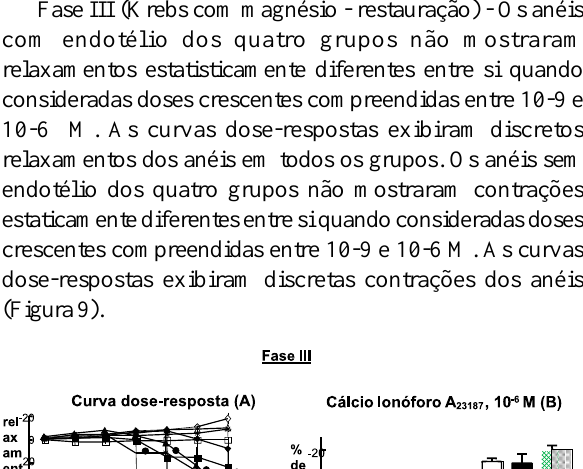
Fig. 8 - Fase II (Krebs sem magnésio): A - Curvas dose- respostas cálcio ionóforo (A ) em anéis de artérias coronárias 23187 caninas, contraídas com PGF a (2 x 10 -6 M), na presença de 2 indometacina (10-5 M); B - Efeitos da dose 10-6 M de cálcio ionóforo (A ) em anéis de artérias coronárias caninas, 23187 contraídas com PGF2a (2 x 10-6 M), na presença de indometacina (10-5 M). (SEM CEC = grupo controle, CEC = grupo de animais submetidos a 110 min de circulação extracorpórea, ISQ = grupo de animais submetidos a 45 min de isquemia, ISQ/REP = grupo de animais submetidos a 45 min de isquemia e 60 min de reperfusão, E (+) = anéis com endotélio, E (-) = anéis sem endotélio. Valores em porcentagem de relaxamento sob a forma de médias ± erros-padrão ). (n = 6).